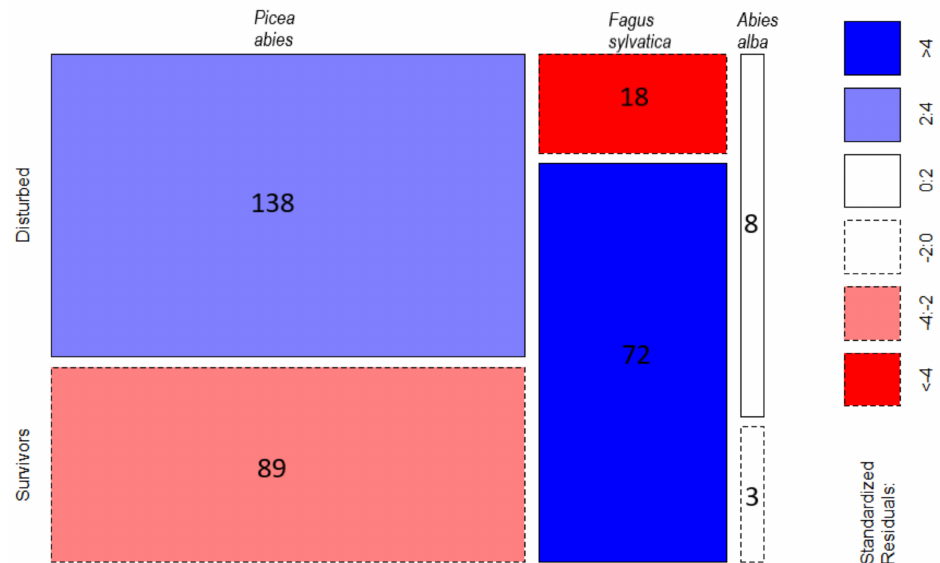
Figure 7. Mosaic plot of the frequencies of tree species distribution based on disturbed (observed) and survivor (expected) data sets. The area of cells is proportional to the frequency of elements in a contingency table. The color of the mosaic represents the relative magnitude of the value, based on standardized residuals, where blue indicates a higher value than expected and red indicates a lower value than